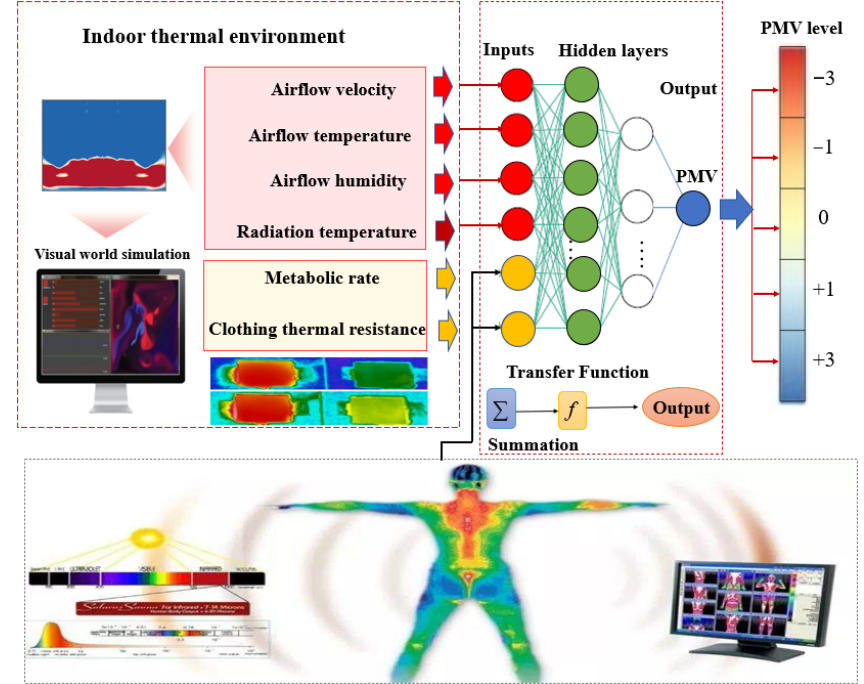
Figure 22. Neural network structure and computational process.